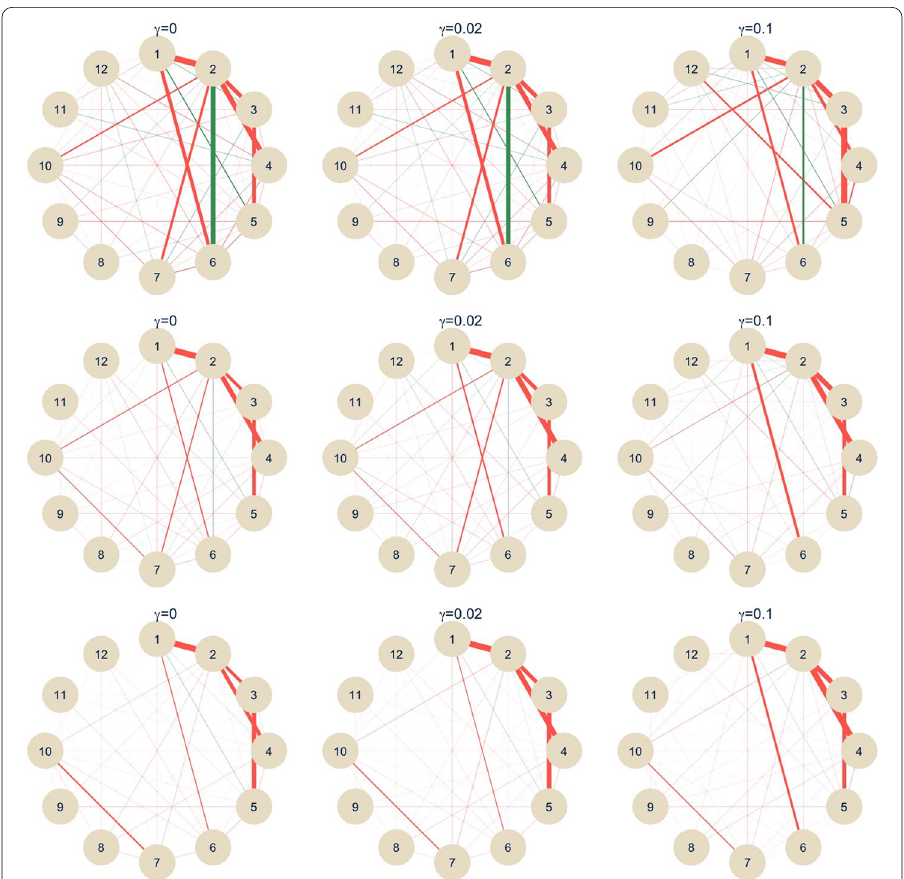
Fig. 7 Conditional correlations around September 8 2019, using the bandwidth parameter h = 20 (first row), h = 50 (second row) and h = 100 (third row). The parameter γ refers to the robustness parameter: γ = 0 means no robust